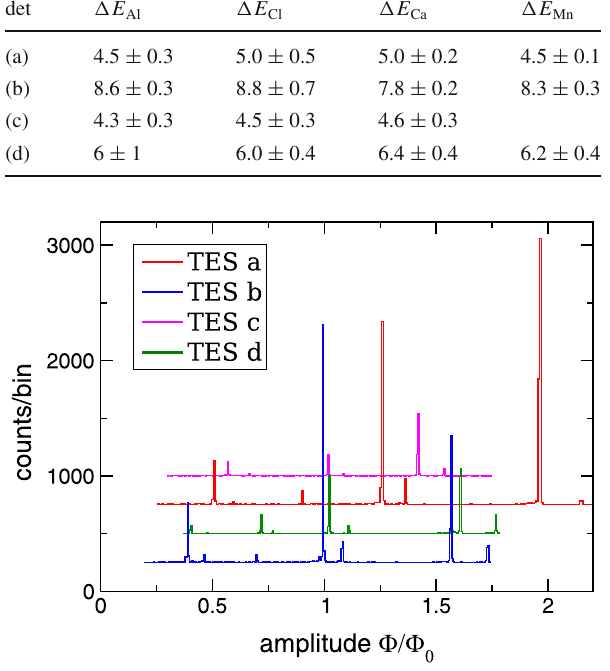
Fig. 6 Full energy range spectra obtained with the 4 designs in flux quanta units: due to the inductive coupling in our design, 1 φ 0 is equal to ∼ 11 µ A of current flowing in the TES. From the left to the right, the energy peaks are due characteristic X-ray of aluminum, chlorine, calcium and manganese. In the case of detectors ( c ) the manganese peak is not present because of limited dynamic range of this particular detector operated at this working point. The smaller pulse height of the detector ( d ) is due to the larger heat capacity respect to the other geometries, while for detector ( b ) the different design of the